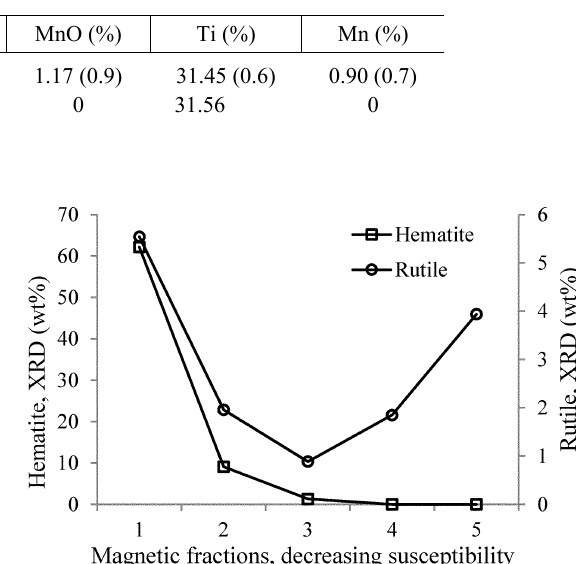
Table 11. Average results of the scanning electron microscopy with energy dispersive X-ray spectroscopy microanalysis of Lemme ilmenite (the standard deviation is shown in brackets) and a comparison with pure ilmenite (FeTiO 3